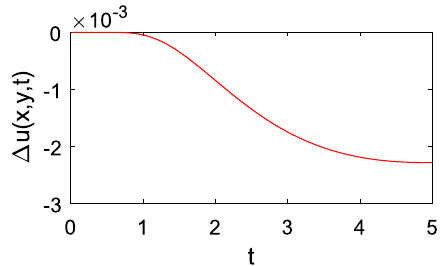
Figure 2. Time history of (cid:31) u at the point ( 6, 6 ) .